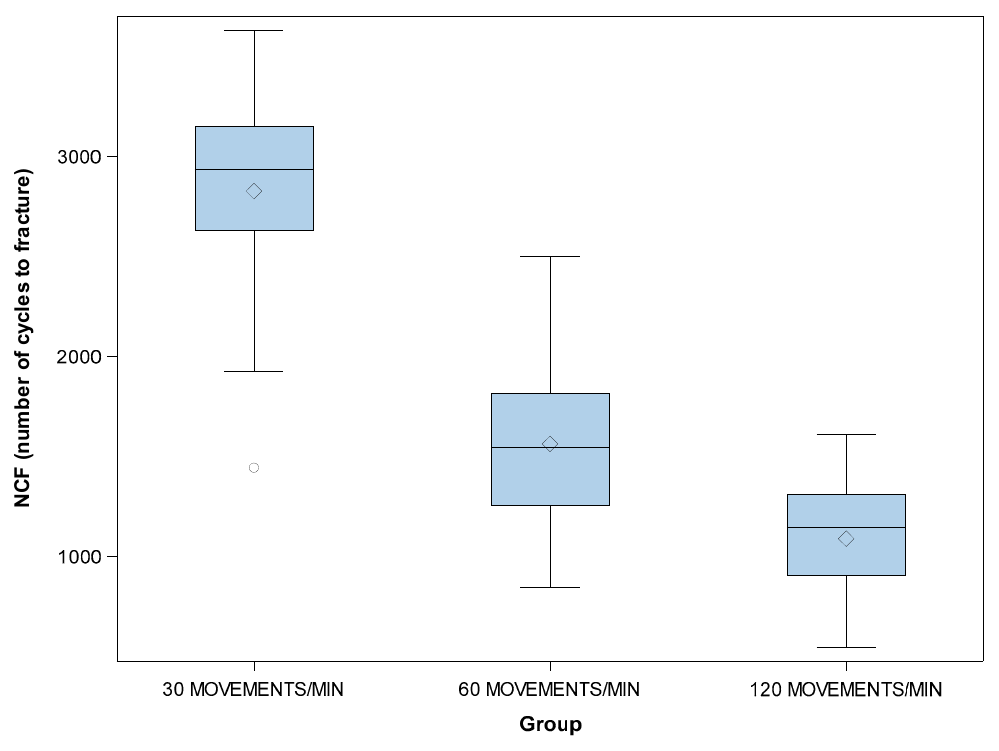
Figure 5. Weibull probability plot of the time to failure.